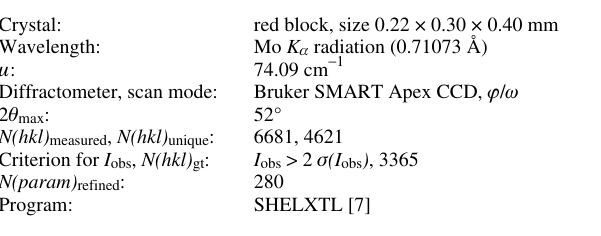
The title crystal structure contains the mononuclear cobalt(II) complexes. In the molecule, cobalt(II) atom is in a distorted tetra- hedral manner four-coordinated by two N atom and two O atoms from two independent Schiff base ligands. The average bond lengths of Co1—O and Co1—N are 1.907(3) and 1.992(3) Å, re- spectively. The angles subtended at the Co(II) ion of the distorted tetrahedral geometry (CoN 2 O 2 ) are in the range 95.1(4)° - 123.5(4)°. The dihedral angle between the six-membered rings